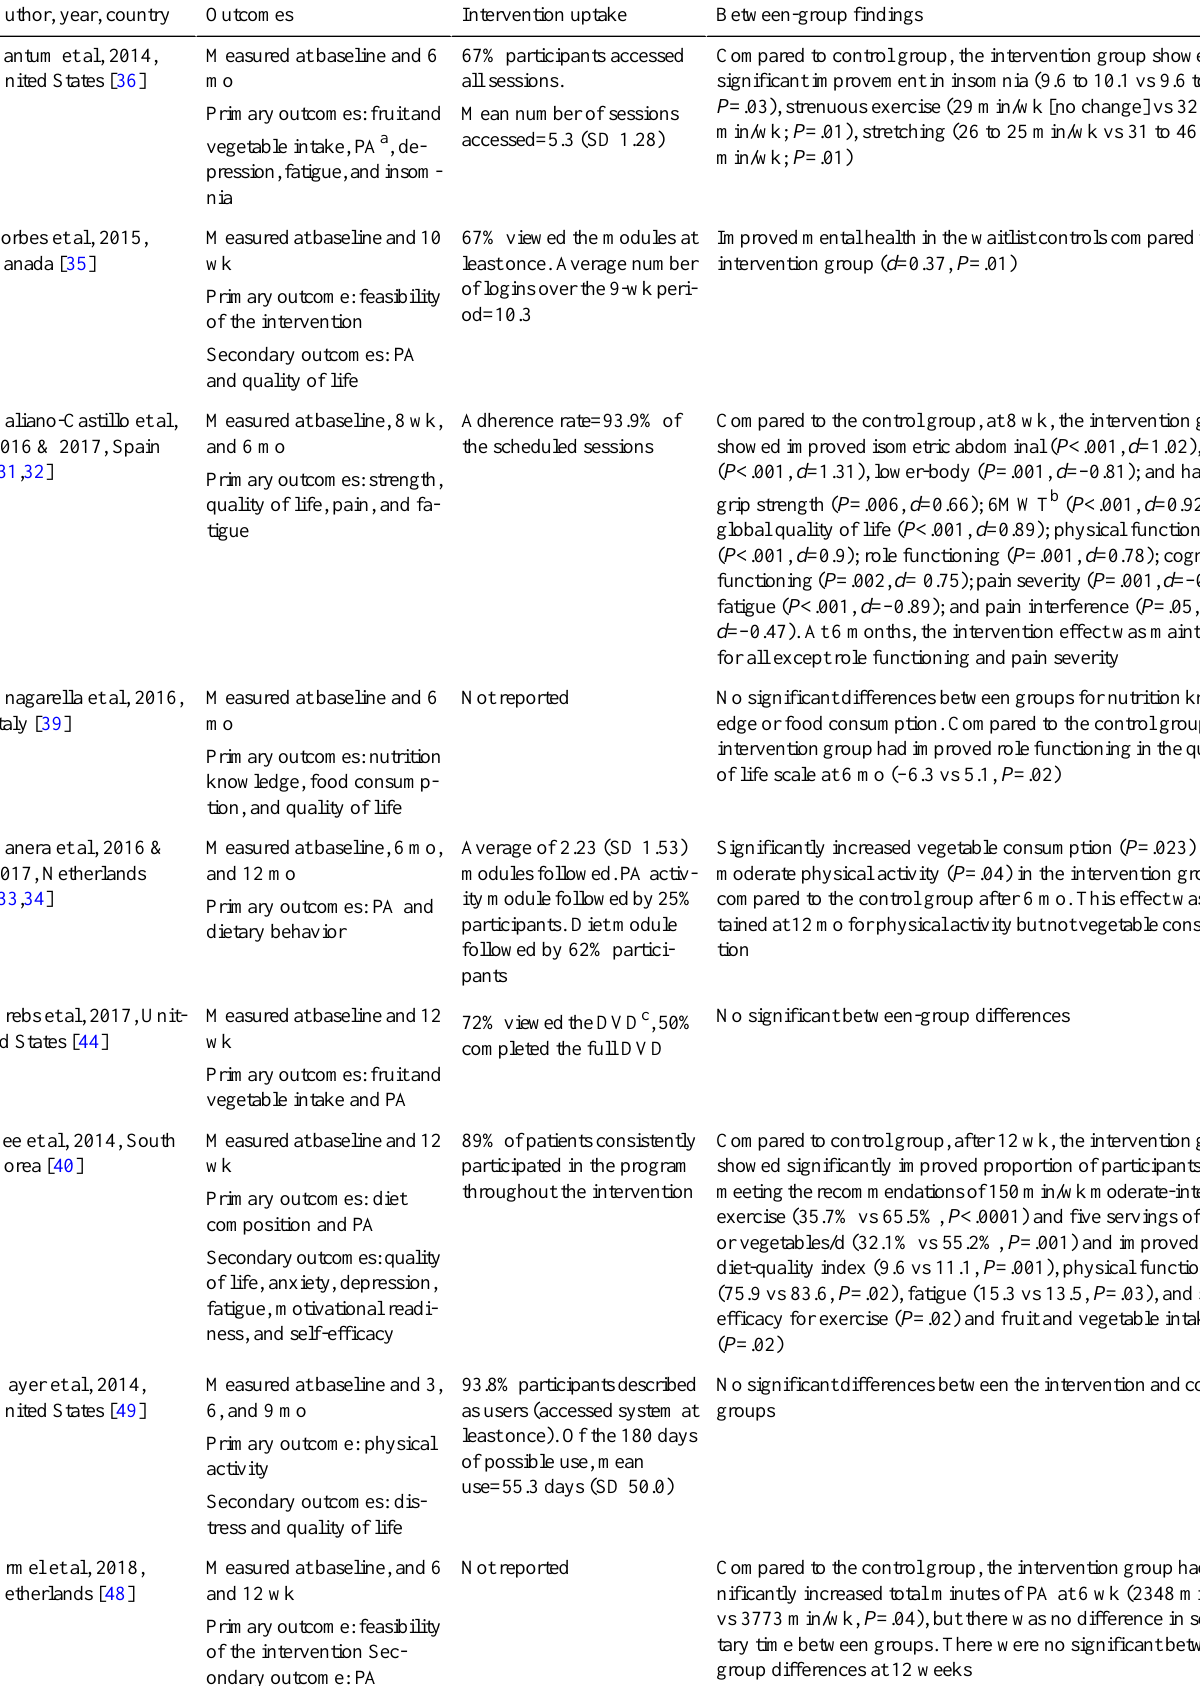
Table 2. Outcome measures and findings of the included studies.